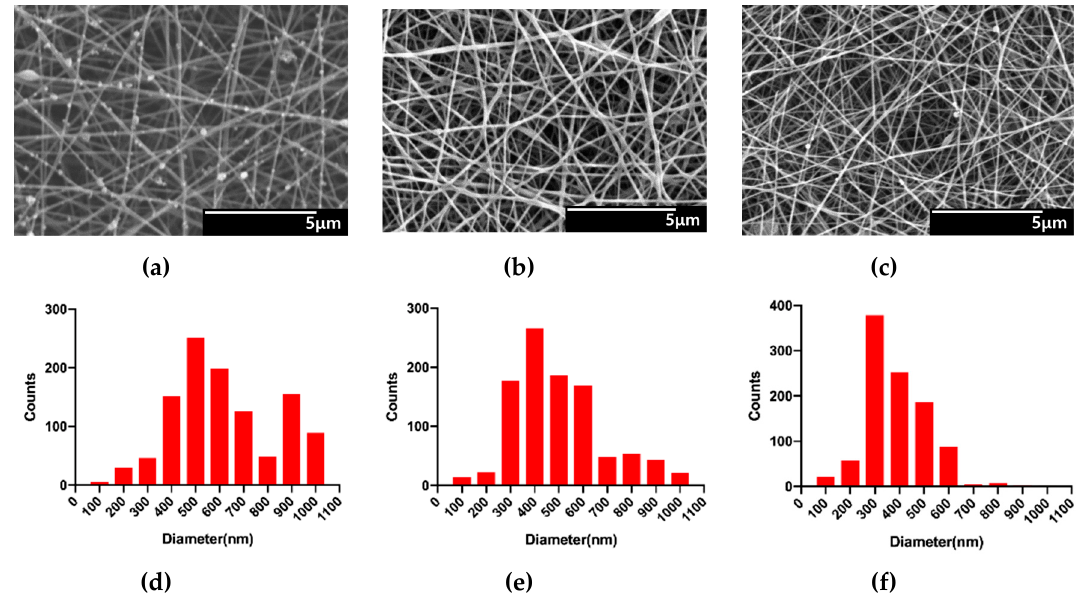
Figure 2. Scanning electron microscopy data and distribution plots for nanofiber-diameter alginate/CMC/PEO nanofiber films. ( a ) and ( d ) are data obtained from 1% ( w/v ) alginate/CMC/PEO nanofiber film. ( b ) and ( e ) are data obtained from 7% ( w/v ) alginate/CMC/PEO nanofiber film. ( c ) and ( f ) are data obtained from 9% ( w/v ) alginate/CMC/PEO nanofiber film.